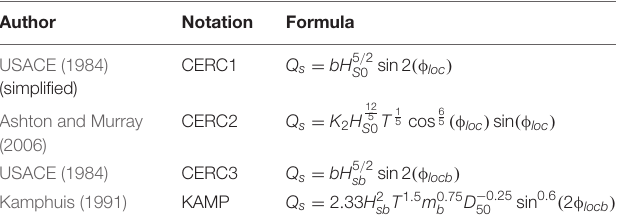
TABLE 1 | Implemented longshore transport